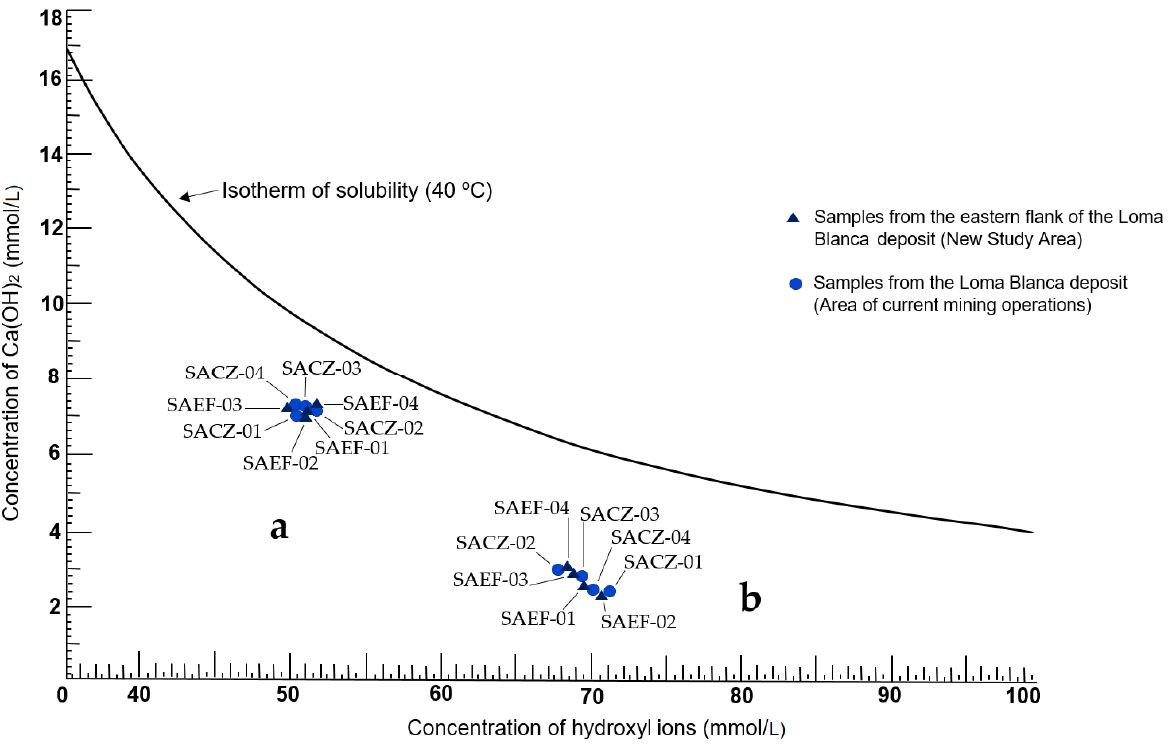
Figure 4. Results of the pozzolanicity analysis of the investigated samples: ( a ) the grouped results of the test at 8 days and ( b ) those corresponding to 15 days.